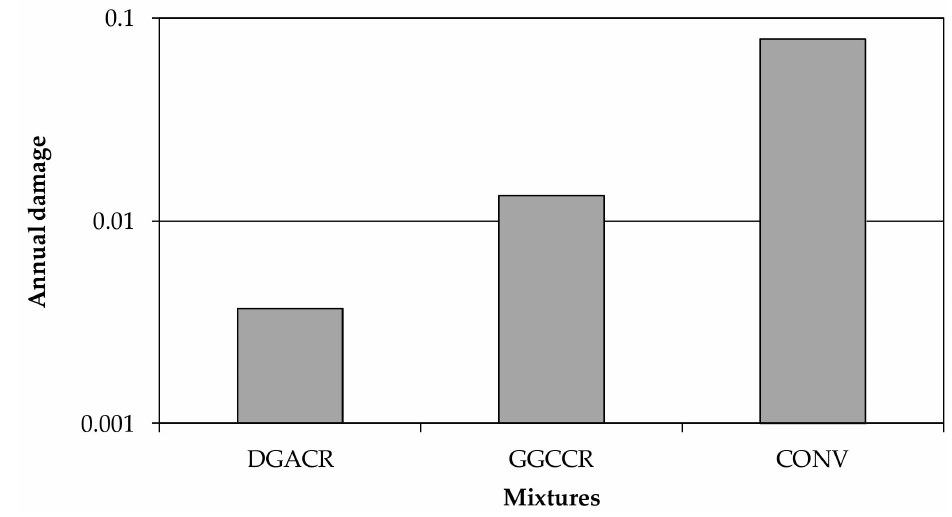
Figure 8. Annual damage for the mixtures as an overlay of 12 cm.